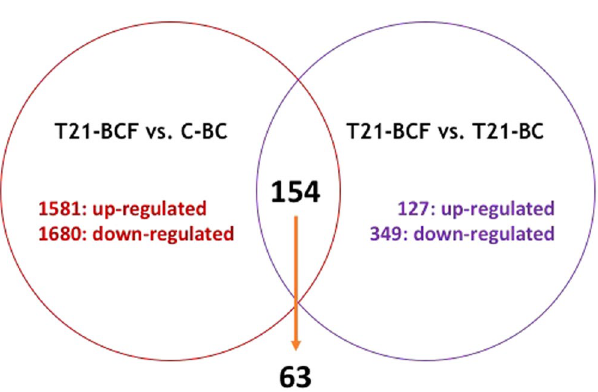
Figure 1. A heatmap of the distance matrix showing the similarities and dissimilarities between samples (T21- BCF; T21-BC; C-BCF; and C-BC). The normalized data are used in this figure for sample clustering. Distance between C-BC and T21-BC is the greater indicating the maximum dissimilarities between samples.